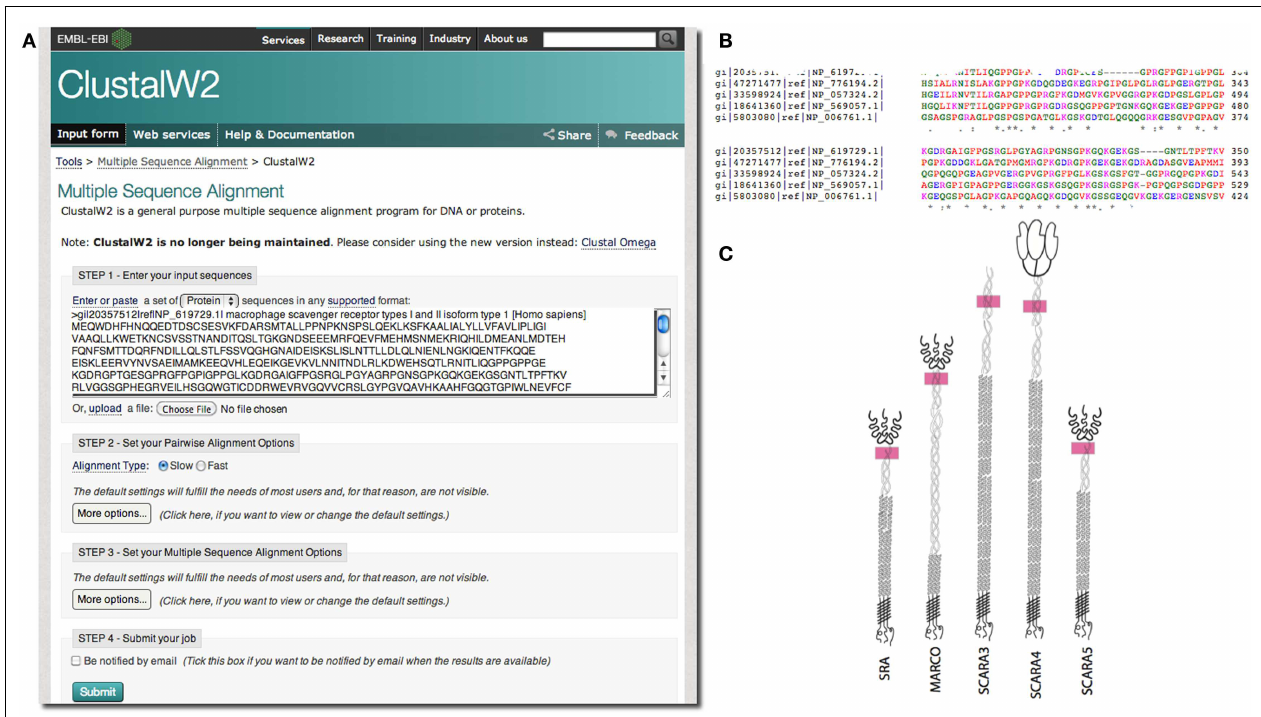
sulfhydryl, amine, and glycine). Coloring allows the viewer to visualize the distribution of charge and hydrophobicity in the protein. In this example, we see that there is an orderly distribution of hydrophobic amino acids (red).The degree of consensus is represented with symbols. (*) Indicates positions which have a single, fully conserved residue; (:) indicates conservation between groups of strongly similar properties; (.) represents conservation between groups of amino acids with weakly similar properties.The fact that all five members of this family share this highly conserved region at locations in these proteins indicated with pink rectangles, (C) , and that it is the highest area of conservation within the proteins is strongly suggestive of a conserved